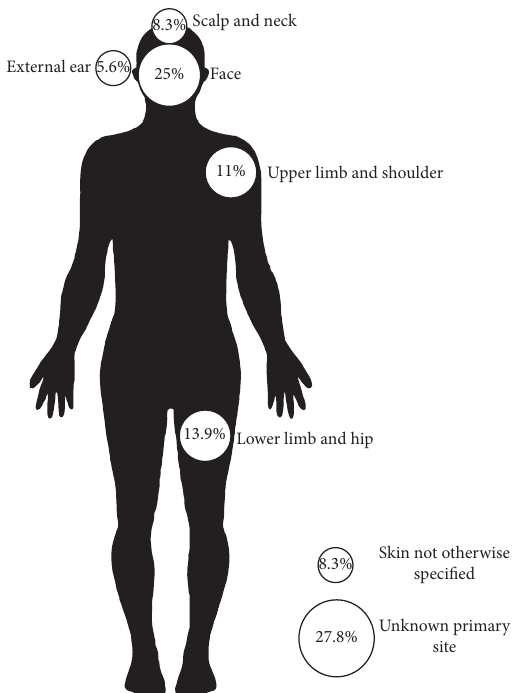
Figure 1: Tumor localization.